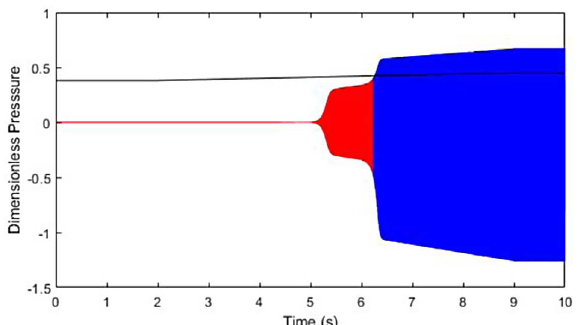
Figure 9. Signal (dimensionless acoustical pressure) obtained by simulation in time domain with an inharmonicity Inh = 0.015 and Z 1 = Z 2 /1.5 (like in Fig. 7b). The dimensionless mouth pressure is printed in black, and is increasing linearly from c = 0.38 (constant before t = 2 s) to c = 0.45 (constant after t = 9